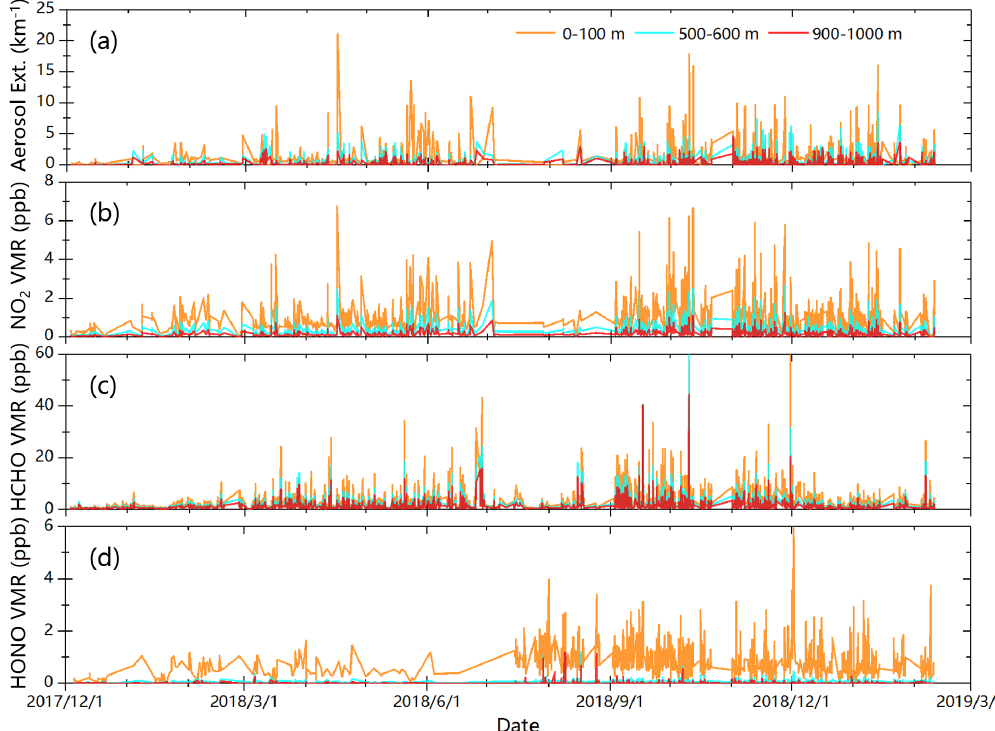
Figure 6. Time series of hourly averaged (a) aerosol extinction, (b) NO 2 , (c) HCHO and (d) HONO from December 2017 to February 2019 at CAS (QOMS).